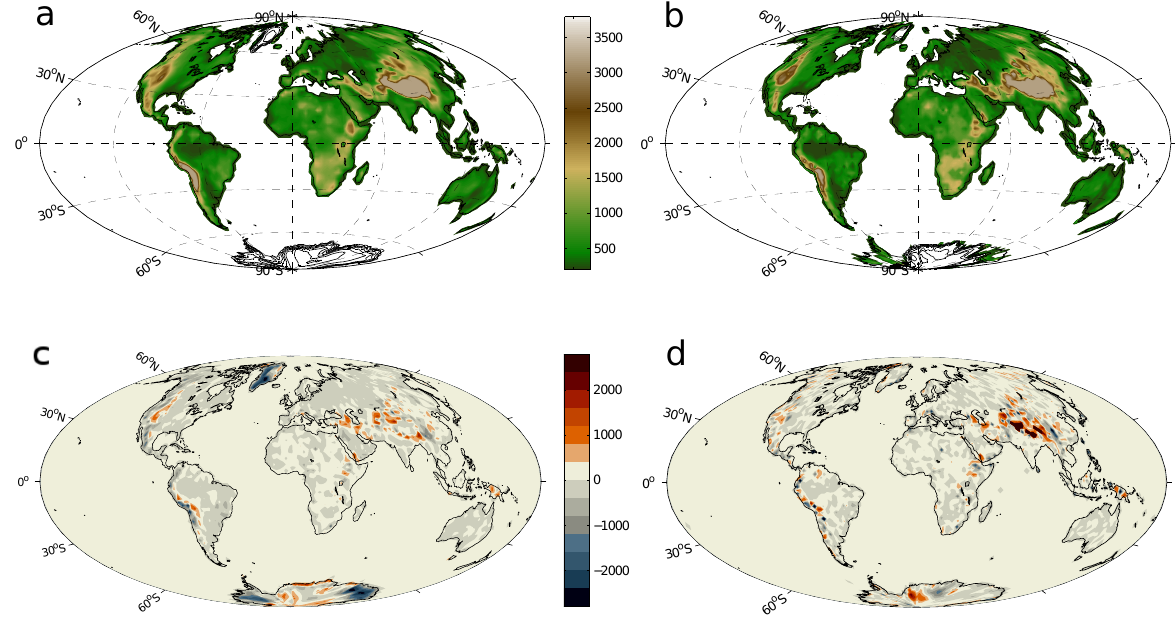
Fig. 2. Boundary conditions. Absolute global topography [m] for (a) pre-industrial ( Topo pre.genesis ), and (b) mid-Pliocene ( Topo plio.genesis ) experiments. Mid-Pliocene final topography is calculated using an anomaly approach (see text). Elevation differences [m] (c) between (b)-(a), and (d) between PRISM pre-industrial ( Topo pre.prism ) and GENESIS pre-preindustrial ( Topo pre.genesis ) datasets.